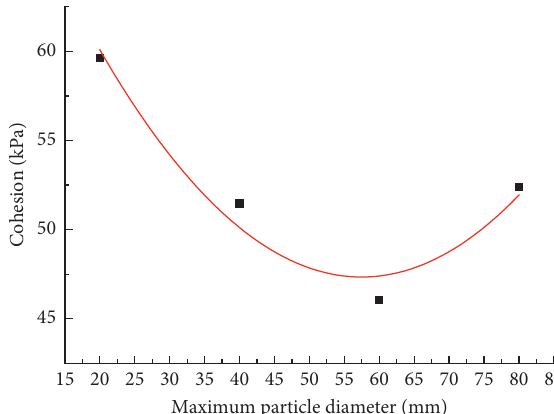
Figure 9: Relationship between cohesion and maximum particle